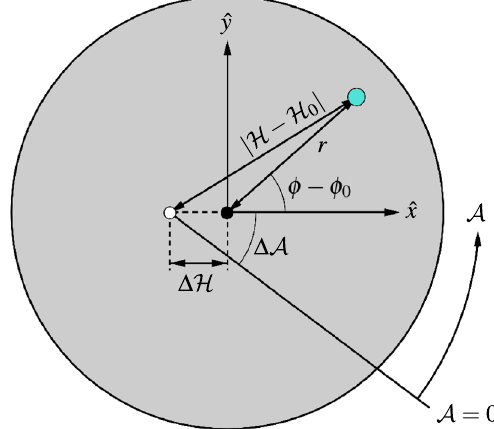
Fig. 18 Schematicofthecoordinatesystemsusedtodescribepositions of the vertical beam in the horizontal plane. The center of the Compton Scanner frame (white point) and the center of the detector (black point) have an offset of Δ H , which is reached at A = Δ A or φ = φ 0 The Cartesian coordinate system is defined with the origin at the center of the detector (black point in Fig. 18) and the ˆ x axis pointing parallel to the line that connects the center of the detector and the center of the Compton Scanner frame (black and white points in Fig. 18). The ˆ x axis does not necessarily need to be aligned with φ = 0 ◦ , see Sect. 3.1, segments1and4.Inthedetectorcoordinatesystem,the ˆ x